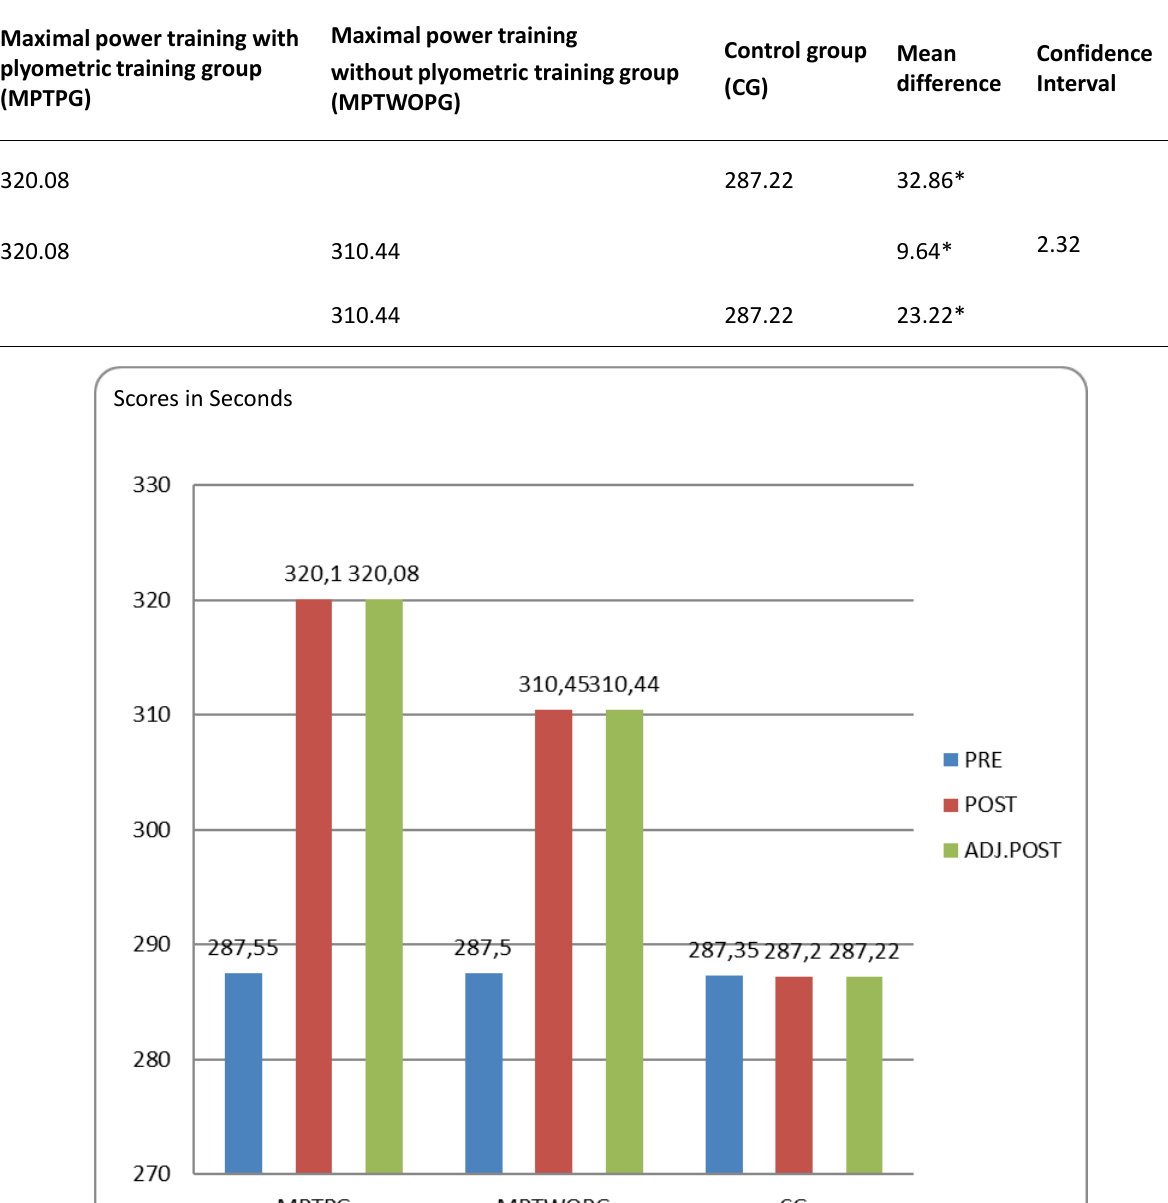
Table 5. Scheffee’s post hoc test for the differences between the paired adjusted post-test means of upper body power